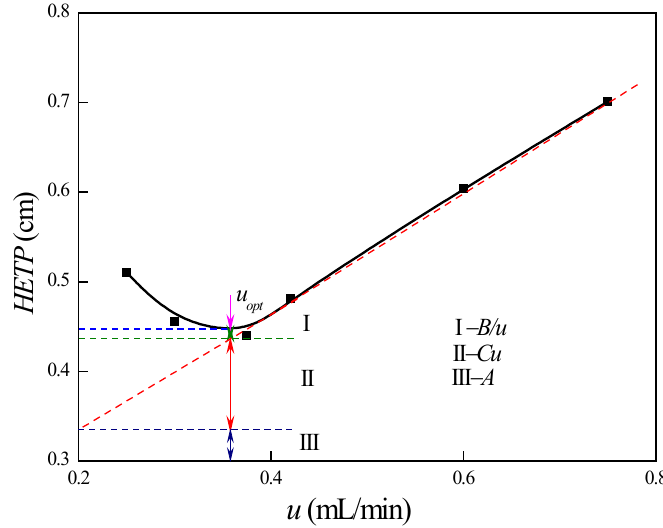
Figure 9. Theoretical tray height curve at different flow rates.